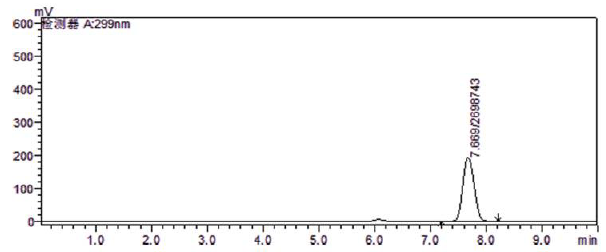
Fig 1. The HPLC Figure of rotenonestandard substance.